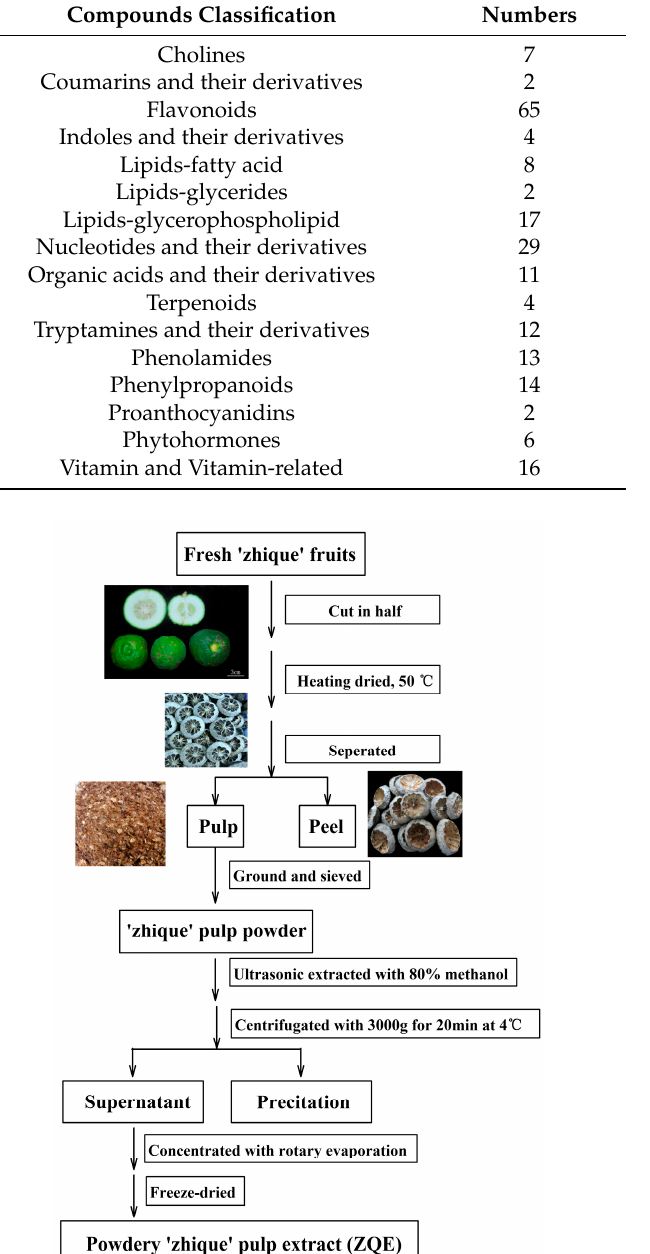
Figure 1. The extraction methods used to isolate ‘Zhique’ pulp extract (ZQE) from ‘Zhique’ fruits.